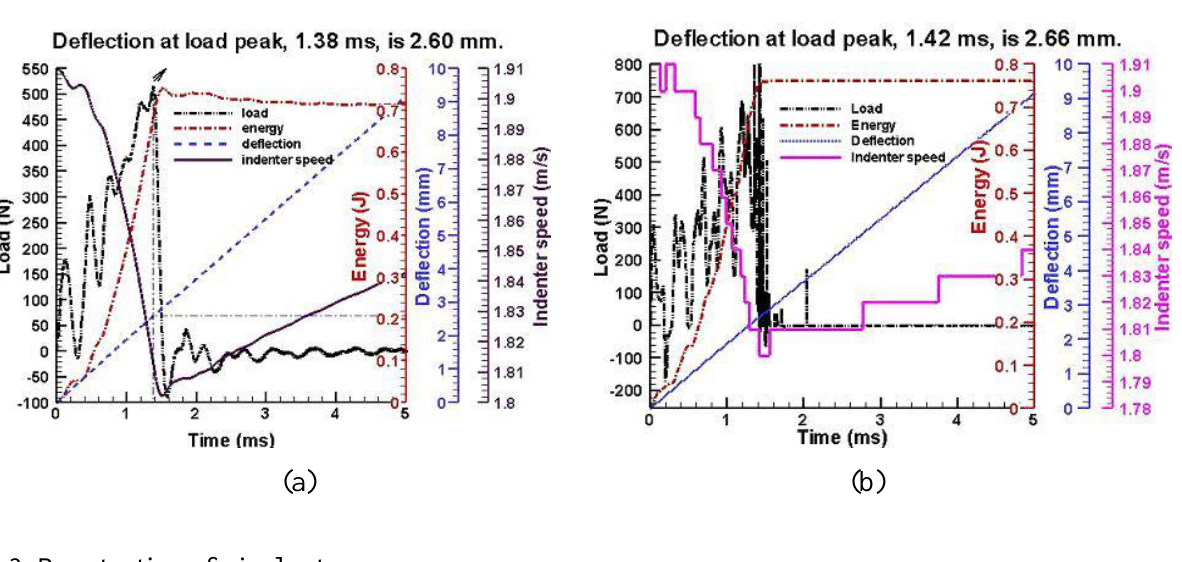
Figure 11. Comparison of HLPM result with the according experimental observation of the failure of vinyl ester due to the impact of a rigid indenter, (a) experimental